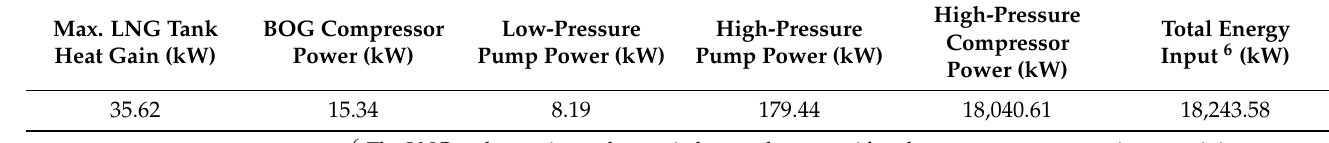
Table 8. Energy balance results for the conventional LNG regasification